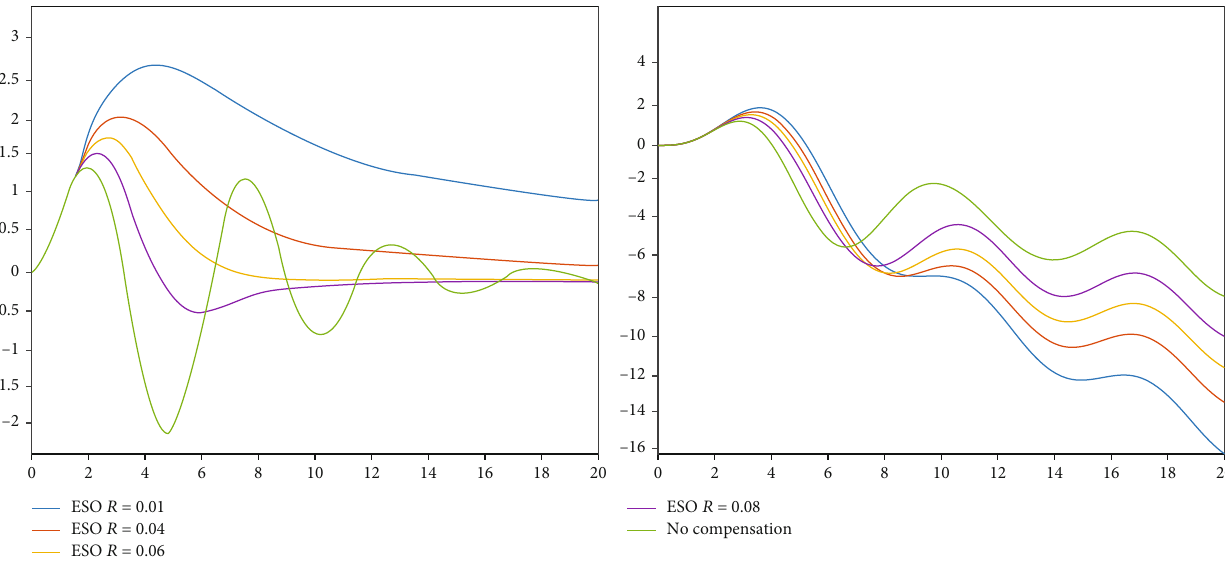
Figure 20: E ff ect of target constant maneuver on dimensionless miss distance under step and wave